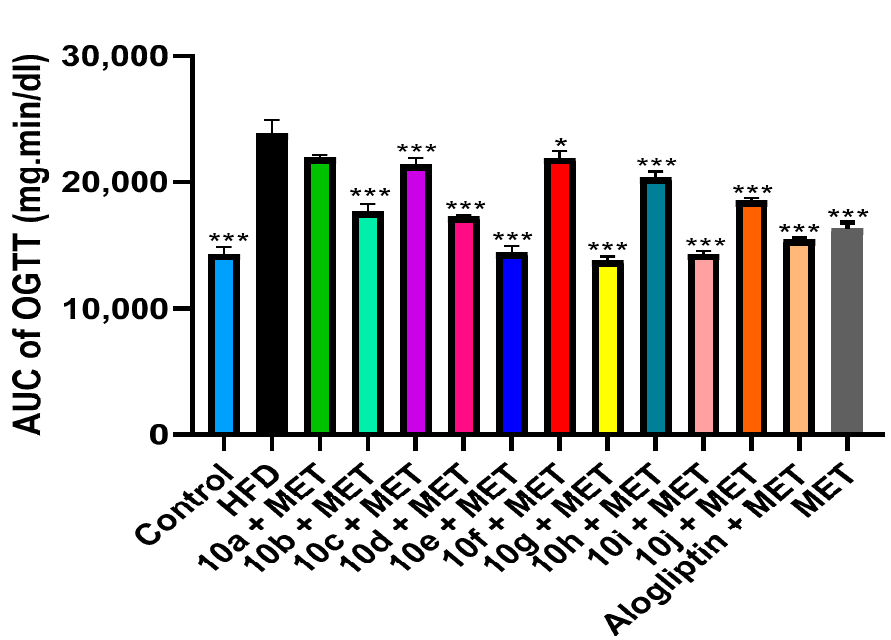
Figure 5. ( a ) Chronic effect of hybrids 10a–j and alogliptin administration on area under the curve (AUC) of OGTT in type 2 diabetic rats. Data are presented as mean ± SEM (n = 7). *** Significant from diabetic control group at p < 0.001, ** Significant from diabetic control group at p < 0.01. ( b ) Chronic effect of combined administration of 10a–j /MET, alogliptin/MET on area under the curve (AUC) of OGTT in type 2 diabetic rats. Data are presented as mean ± SEM (n = 7). *** Significant from diabetic control group at p < 0.001, * Significant from diabetic control group at p < 0.05.